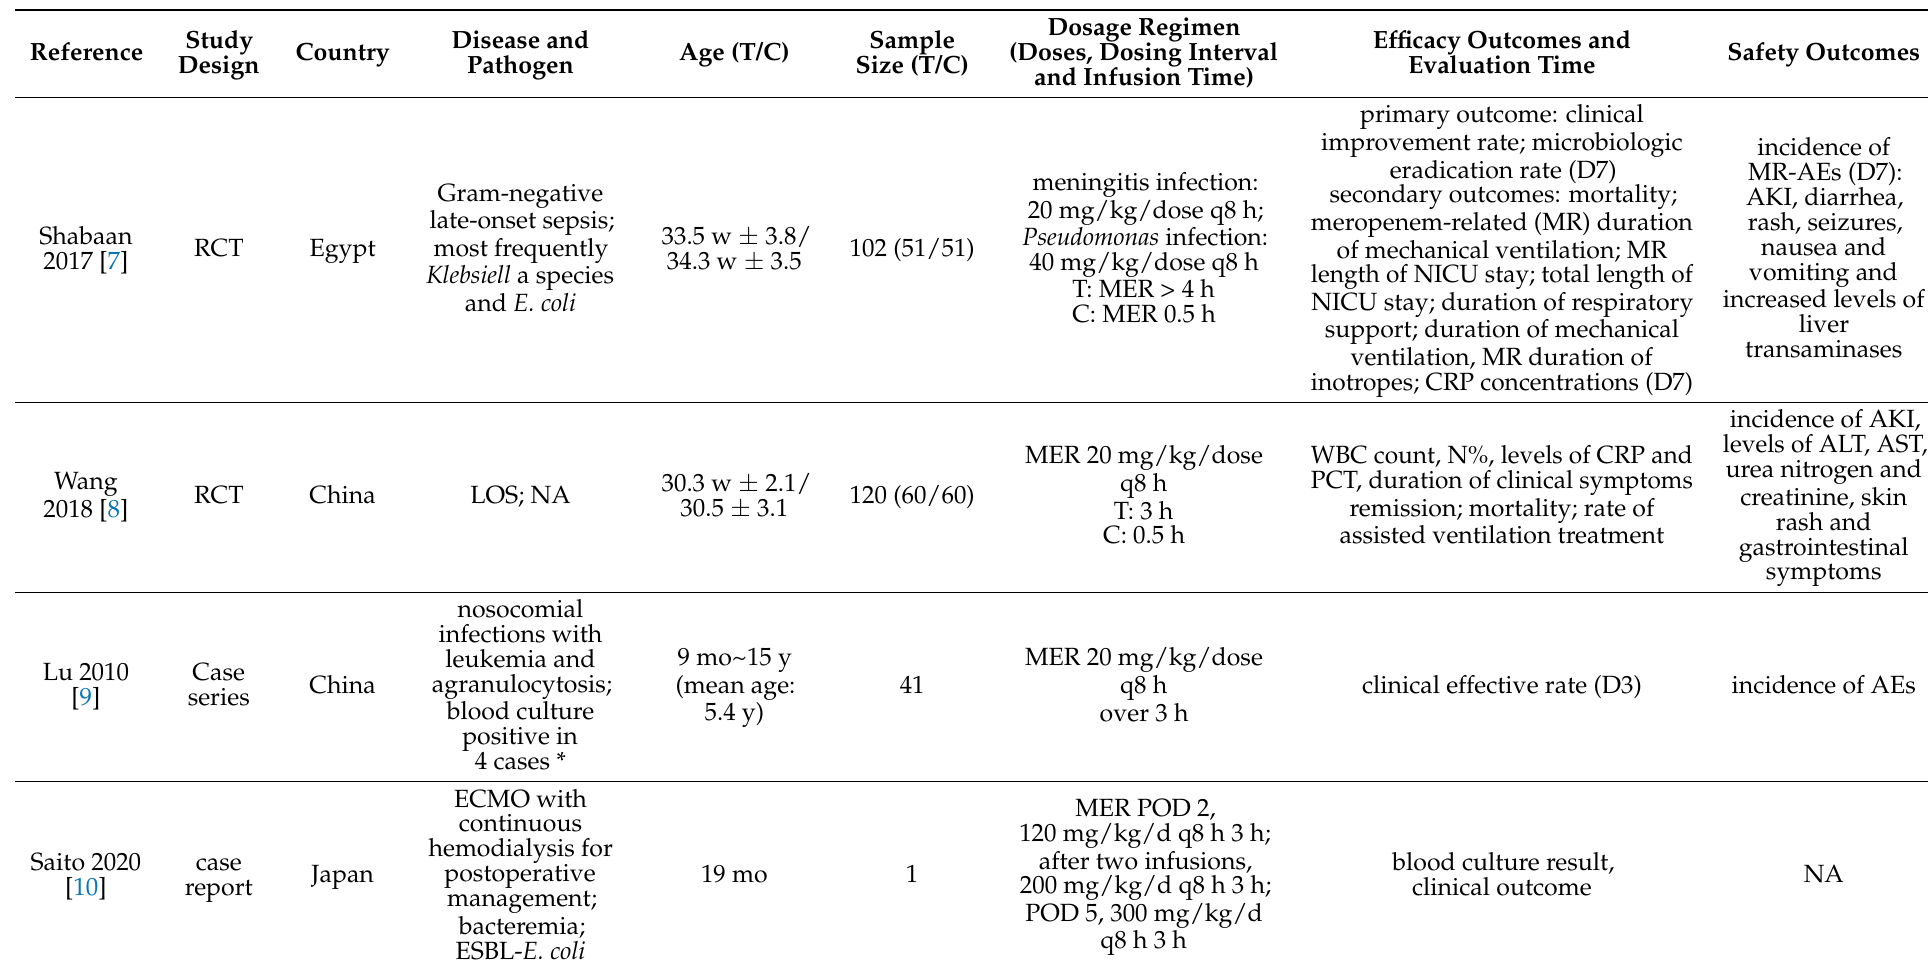
Table 1. Basic information of included RCTs and retrospective